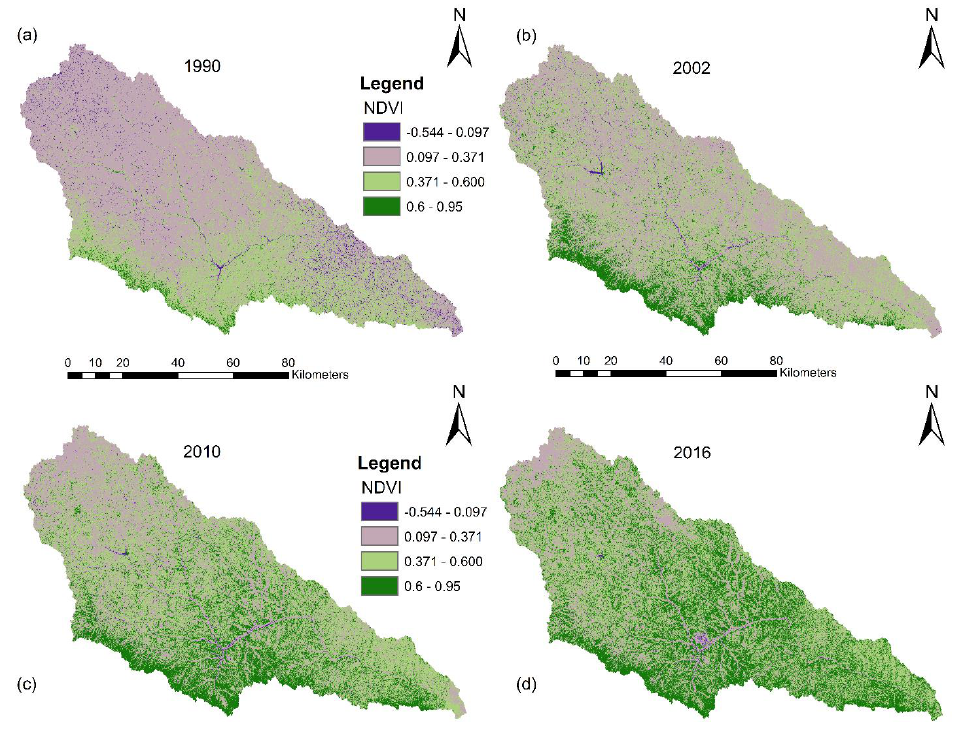
Figure 7. Spatial variations of the NDVI of the Yanhe watershed for 1990 ( a ), 2002 ( b ), 2010 ( c ) and 2016 ( d ).